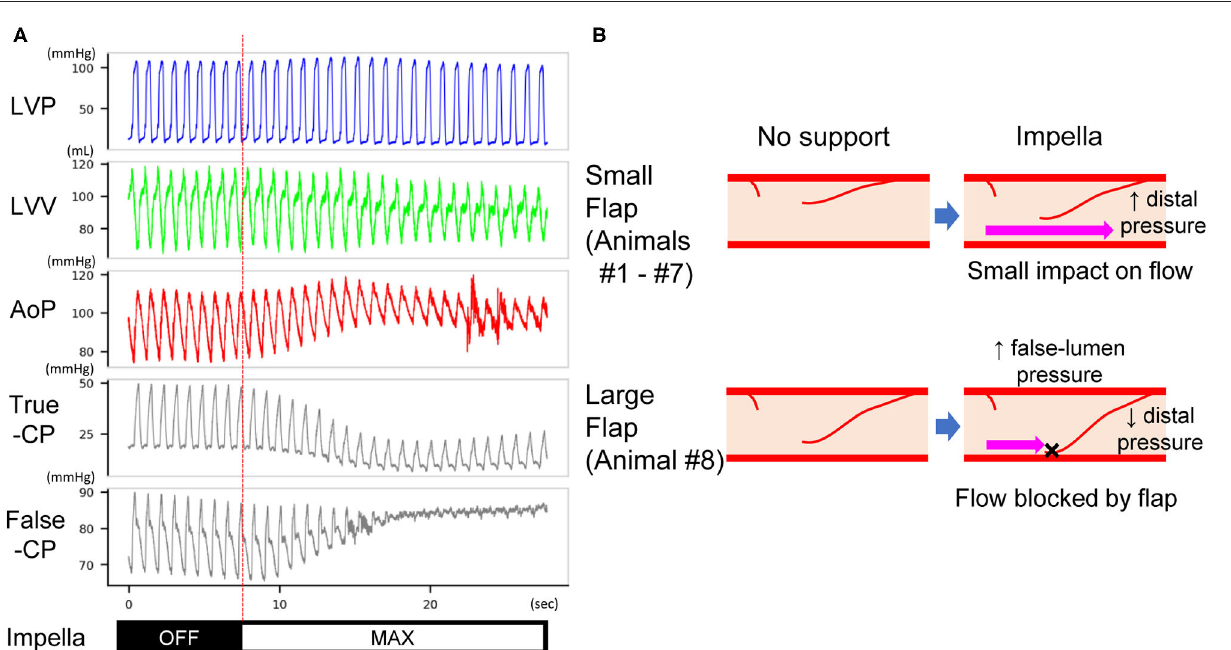
FIGURE 5 | (A) Pressure traces of the LV, true and false lumens of dissected coronary artery in animal #8. After Impella was turned on, the mean pressure of the true lumen decreased, whereas that of the false lumen increased. The length of the traces is 30s. LVP, left ventricular pressure; LVV, left ventricular volume; AoP, aortic pressure; True-CP, pressure of coronary true lumen; False-CP, pressure of coronary false lumen. (B) Expected mechanism of impaired distal (true-lumen) flow at Impella P8. A small flap does not affect the true-lumen flow under maximal Impella support (upper panels). A large flap increases the false-lumen pressure and blocks coronary flow under maximal Impella support (lower panels). This results in a decrease of true-lumen pressure as shown in (A) .